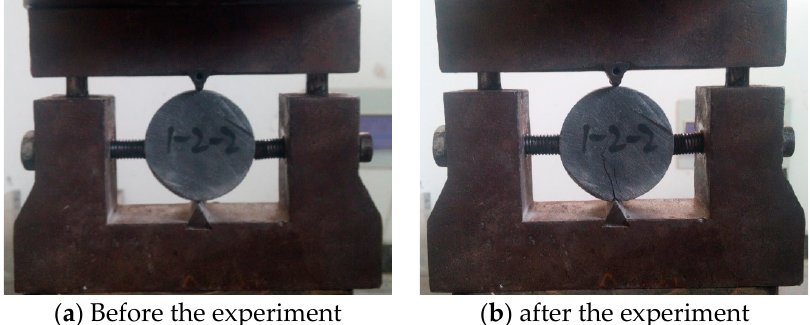
Figure 4. Sandstone sample from the floor of hole No. 3 in the experiment.